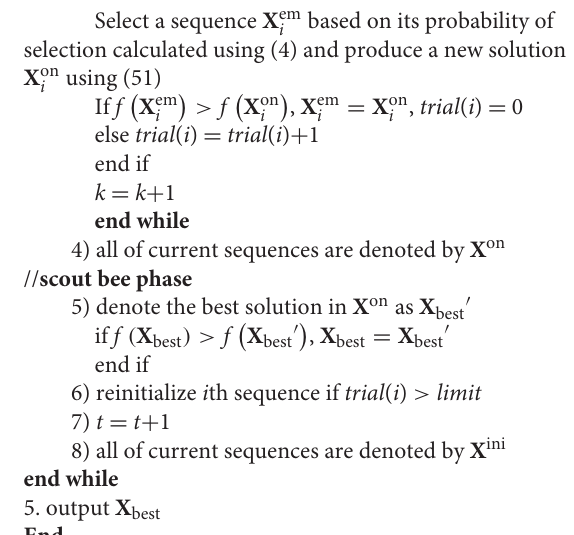
FIGURE 1 | The INS position error.